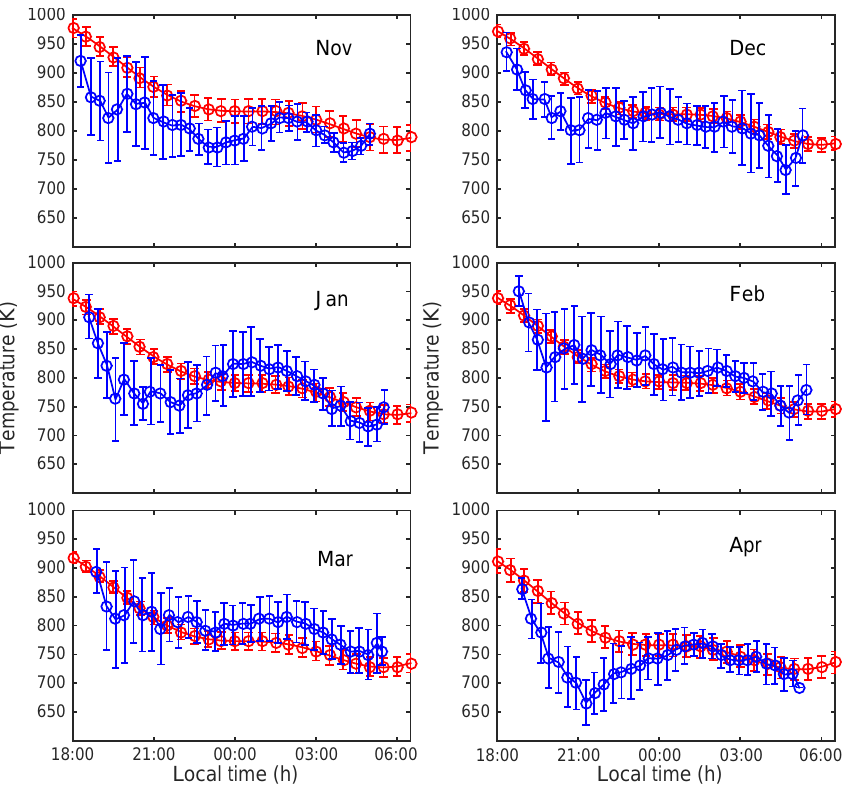
Figure 4. Monthly-averaged temperature observations (blue curves) and MSIS-00 model results (red curves) for an averaging bin period of 20min. The vertical bar for each bin shows the variation in the data within the averaging